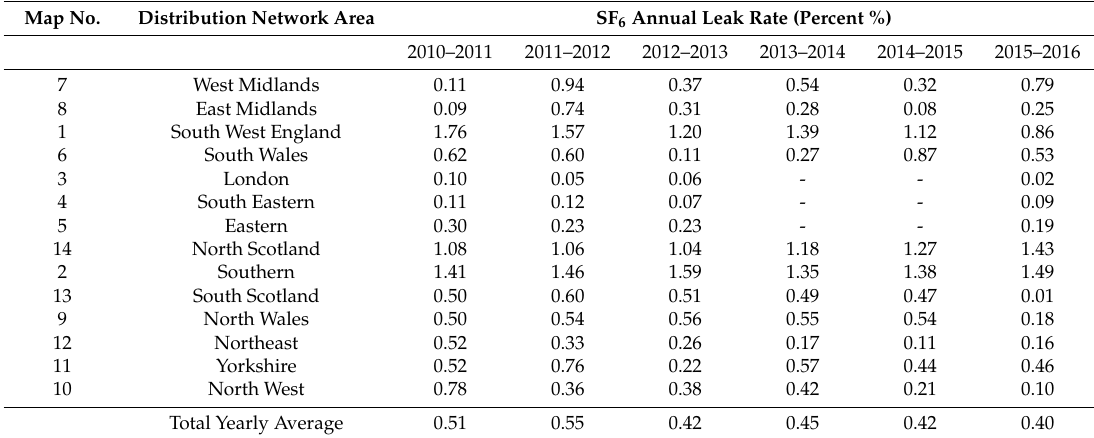
Table 4. Calculated SF 6 annual leak rate of the electricity distribution network (%) in Great Britain. Map No.